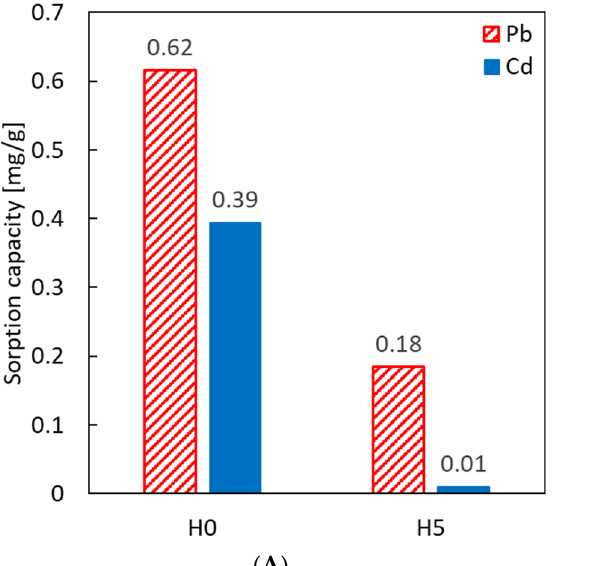
Table 6. Sorption capacity calculated for the raw (H0) and sulphuric acid ‐ treated (H5) sample of halloysite, compared with the reference values [34,35].